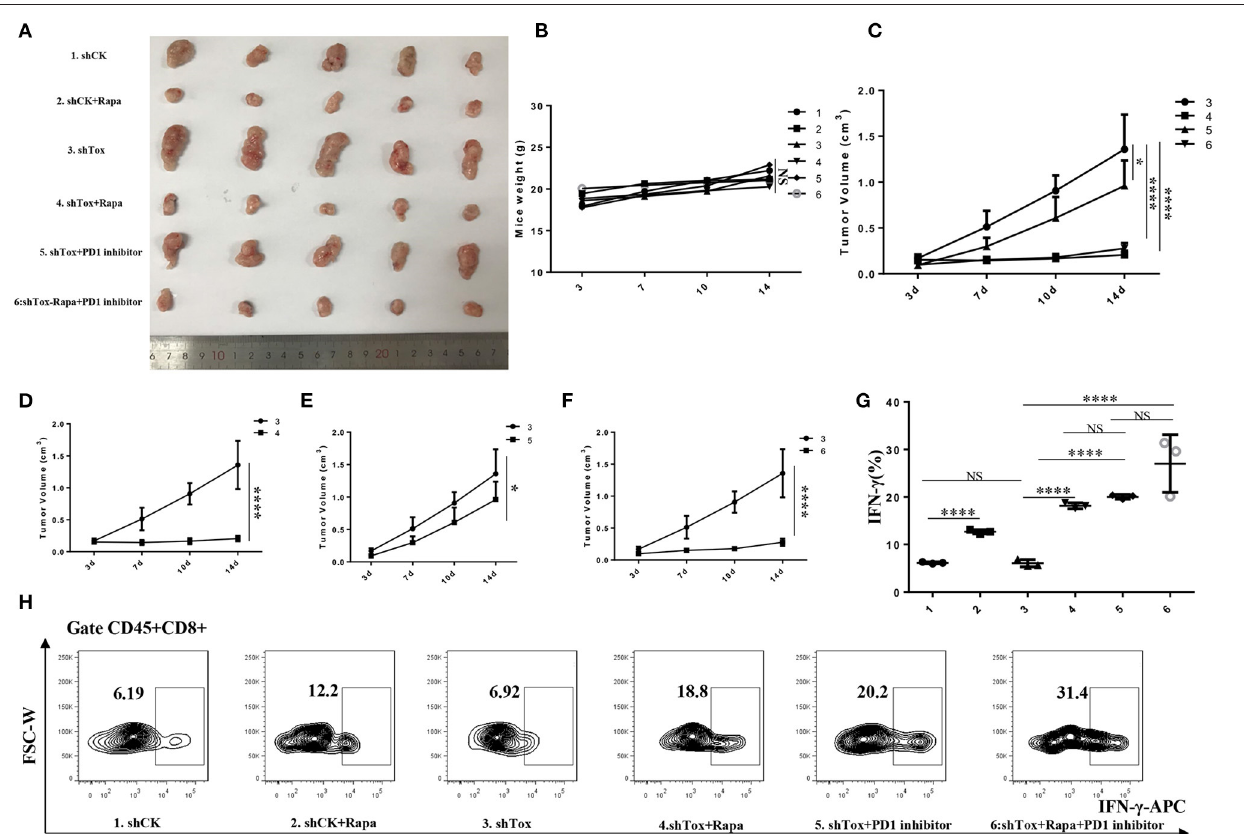
FIGURE 7 | Rapamycin or combined with PD1 inhibition suppresses tumorigenesis. (A) . Tumor samples of 6 groups were shown (1. shCK, 2. shCK + rapamycin, 3. shTox MC38, 4. shTox + rapamycin, 5. shTox + PD1 inhibitor, 6. shTox + rapamycin + PD1 inhibitor). (B) . Mice weights of 6 groups were shown. (C) . The tumor volumes of group 3–6 were shown. The tumor volumes of mice group 3–4 (D) , 3–5 (E) and 3–6 (F) were shown (G,H) . The secretion of IFN- γ by CD8 + T cells in 6 groups mice were shown by FACS. * p < 0.05,**** p < 0.0001, NS: not significant.